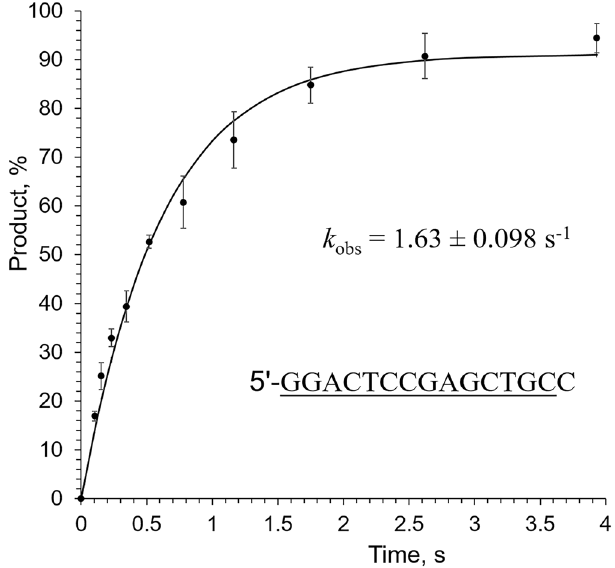
Figure 6. Kinetics of dNMP incorporation into a DNA primer with a ribonucleotide at the 3 ′ -end. Percentage of extended primer was plotted against time and the data fit to a single-exponential equation (Eq. 1). Primer sequence is indicated on the graph with the DNA tract underlined. Reactions, containing 0.44 µM hPolε CD , 0.2 µM template:primer, and 1 mM dTTP, were incubated at 35 °C at the indicated time points. The mean k obs values and standard deviations were calculated from three independent experiments by using GraphPad Prizm